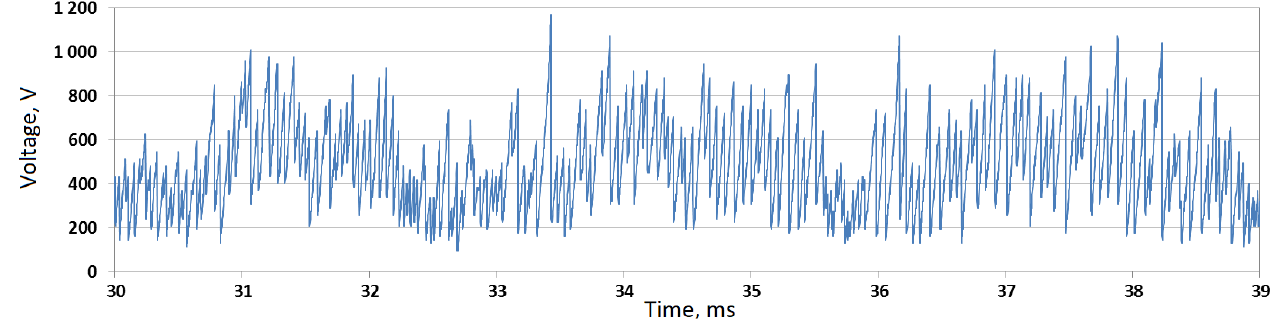
Figure 5. Oscillogram of discharge voltage during flame pulsations.